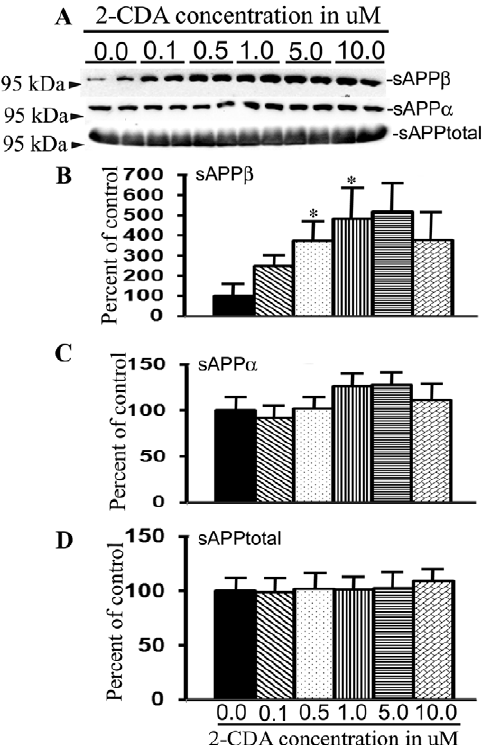
Figure 2. 2-CDA increases sAPP b levels but not sAPP a or sAPPtotal. (A) 7WD10 cells were treated with different concentrations of 2-CDA as indicated and after 48 h the conditioned medium was subjected to immunoblotting to detect different species of sAPPs. (B) sAPP b levels were increased to 250% at 0.1 m M, 375% (p , 0.05) at 0.5 m M, 484% (p , 0.05) at 1.0 m M, 518% at 5.0 m M and 378% at 10.0 m M compared to untreated cells. (C) sAPP a levels were not significantly altered in 2-CDA treated cells versus controls at any of the concentrations. (D) Levels of sAPPtotal were also not altered in 2-CDA treated cells. For all samples, n=4. *, p , 0.05 versus controls by repeated measures ANOVA followed by Dunnett multiple comparison